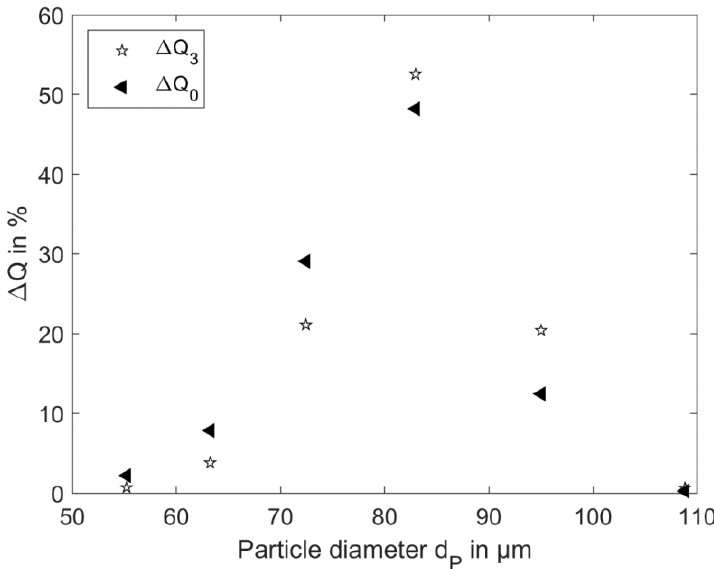
Figure 9. Particle size distribution of the glass particles used in experiments and simulations.